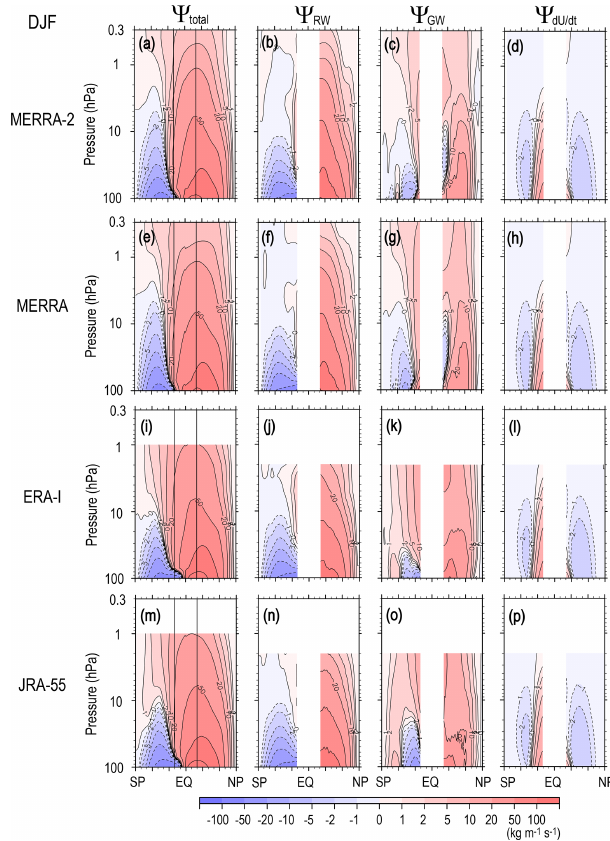
Figure 6. Meridional cross sections of the climatology of the sea- sonal mean stream function of the residual mean flow and potential contributions of RWs (resolved waves), GWs (unresolved waves), and the tendency of zonal mean zonal wind in DJF for MERRA- 2 (from left to right, a–d ), MERRA (e–h) , ERA-Interim (i–l) , and JRA-55 (i–l)